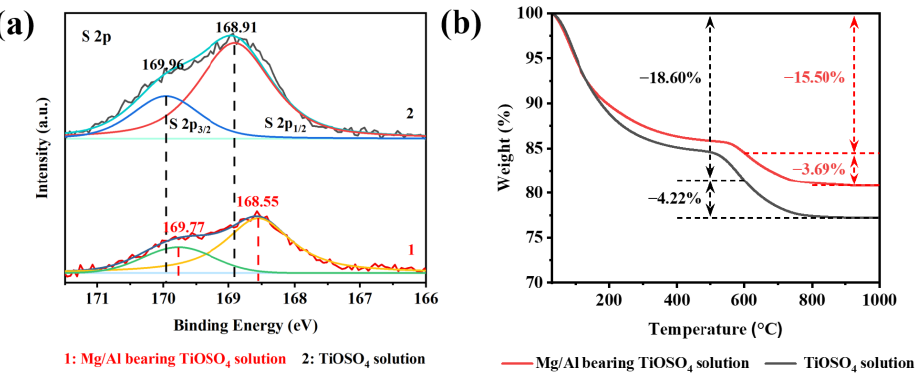
Figure 6. The ( a ) S 2p XPS and ( b ) TGA of hydrated TiO 2 in the Mg/Al-bearing TiOSO 4 solution and the TiOSO 4 solution.